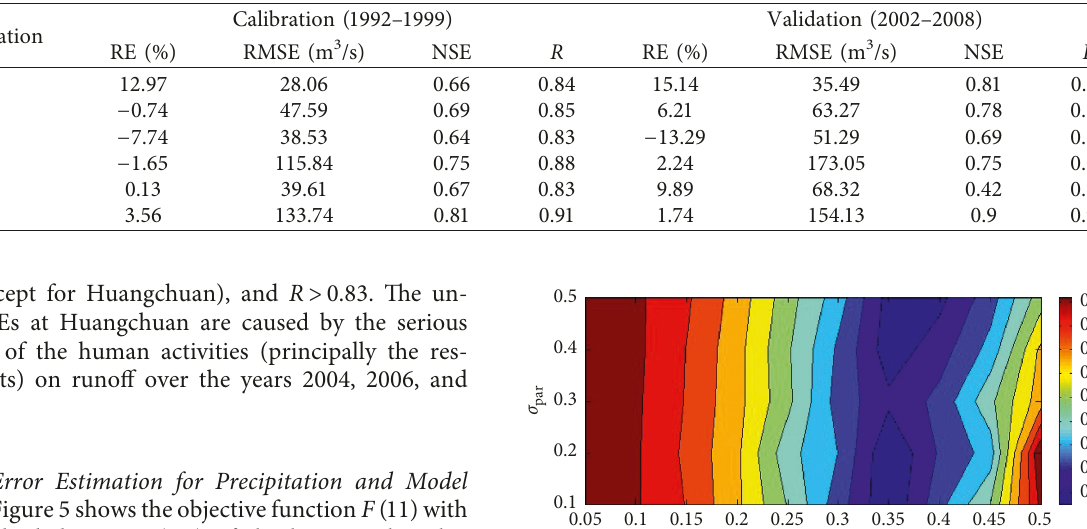
Table 3: Statistical comparison of the observed and simulated daily runoff over the calibration (1992–1999) and validation (2002–2008) periods.